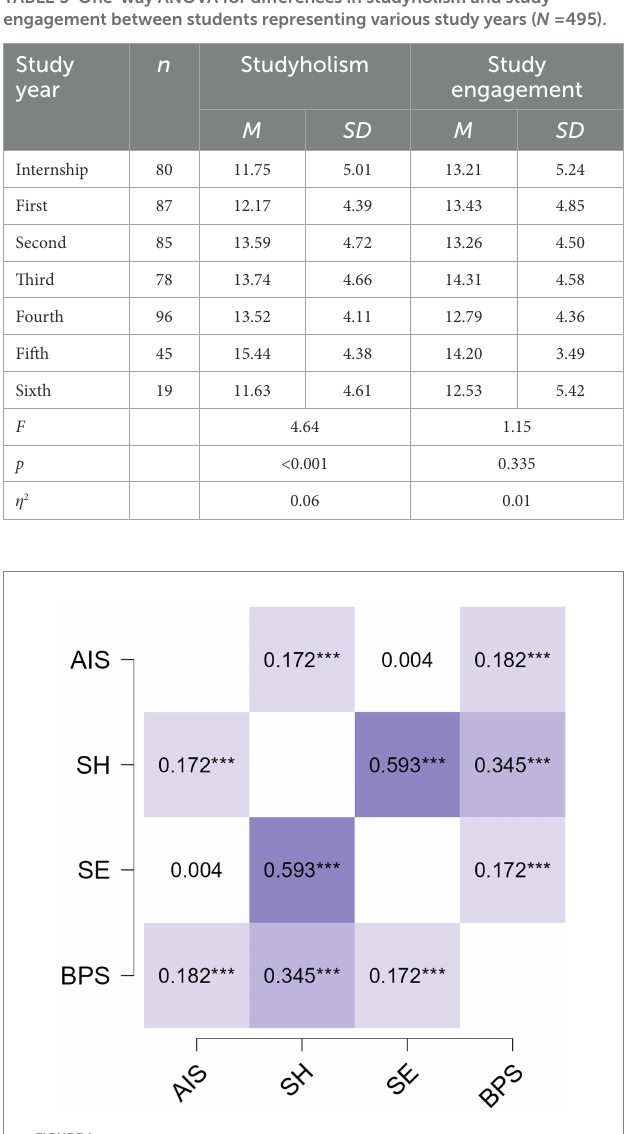
FIGURE 1 Pearson’s correlations between insomnia (AIS), studyholism (SH), study engagement (SE), and bedtime procrastination (BPS). *** p <